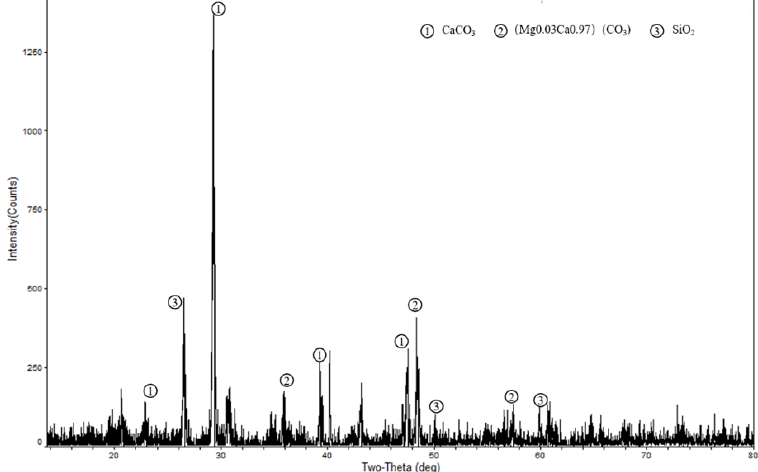
Figure 1. XRD results of limestone.